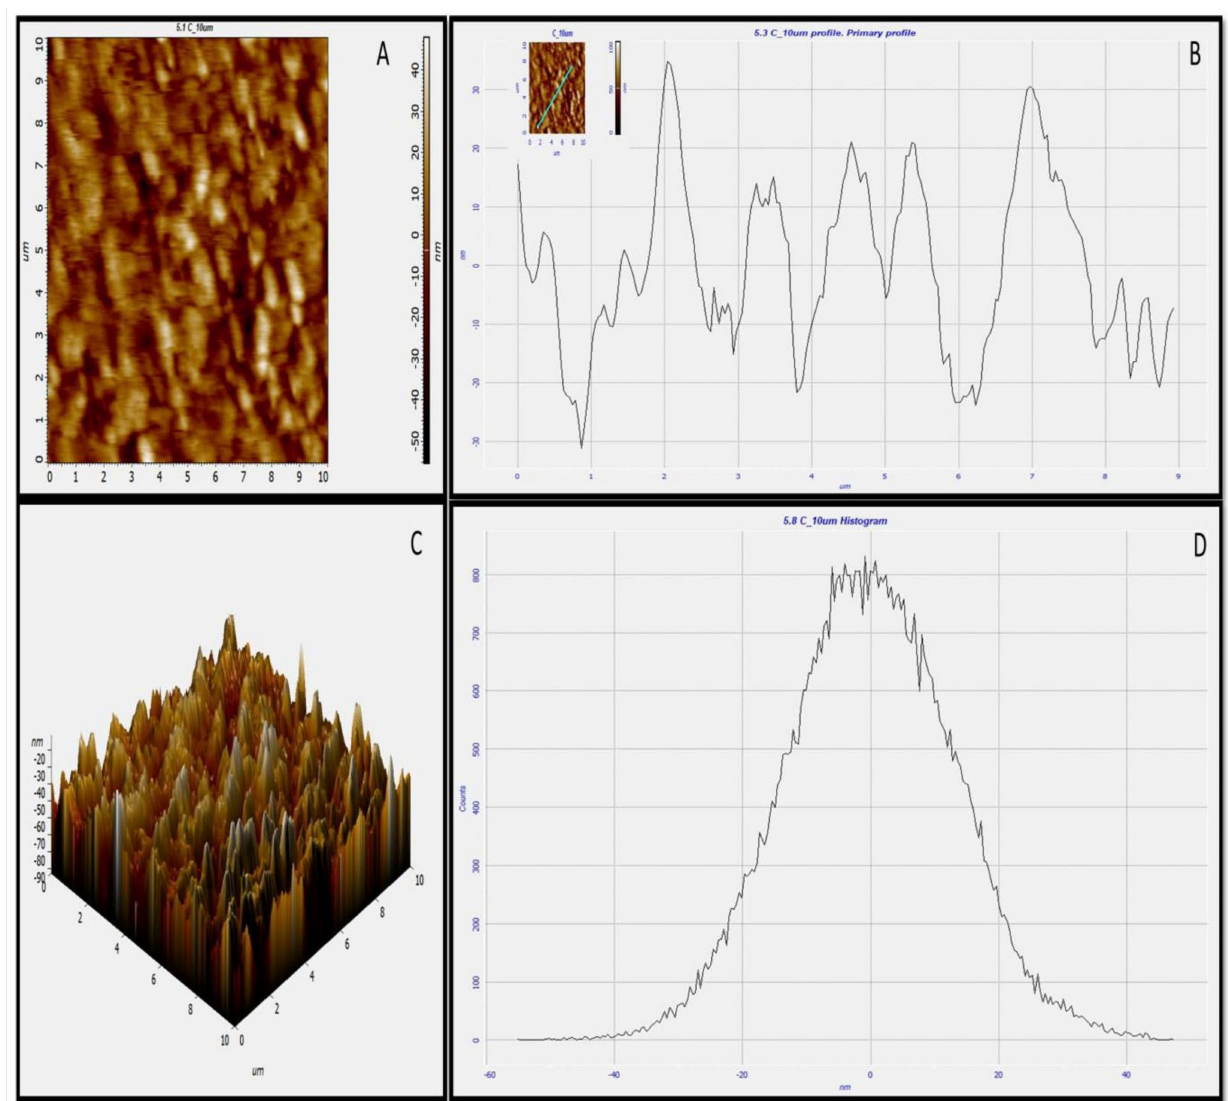
Figure 7. AFM images of green synthesized AgNPs. ( A ) Two-dimensional (2D) image of green AgNPs, ( B ) 2D roughness profile of green AgNPs, ( C ) 3D image of green AgNPs, ( D ) 3D roughness profile of green